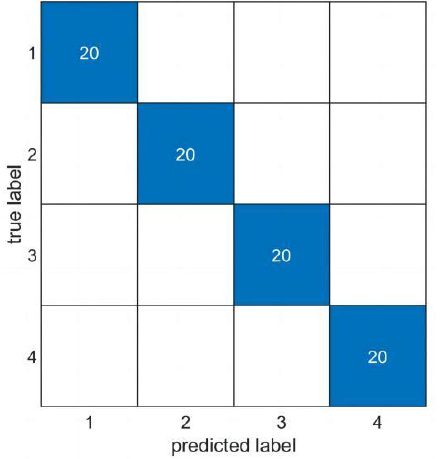
Figure 11. Confusion matrix of ISSA-VMD-DPC.